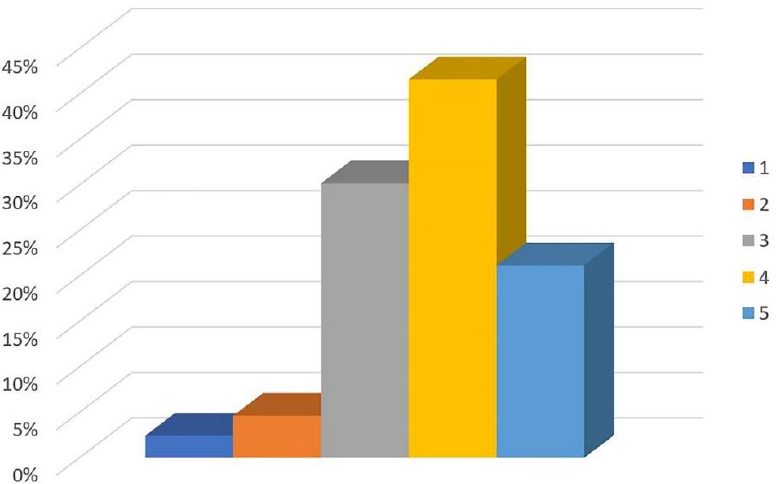
Figure 15. Frequency histogram of all EBA Göltepe chop marks classified by Fragmentation Classes 1 –